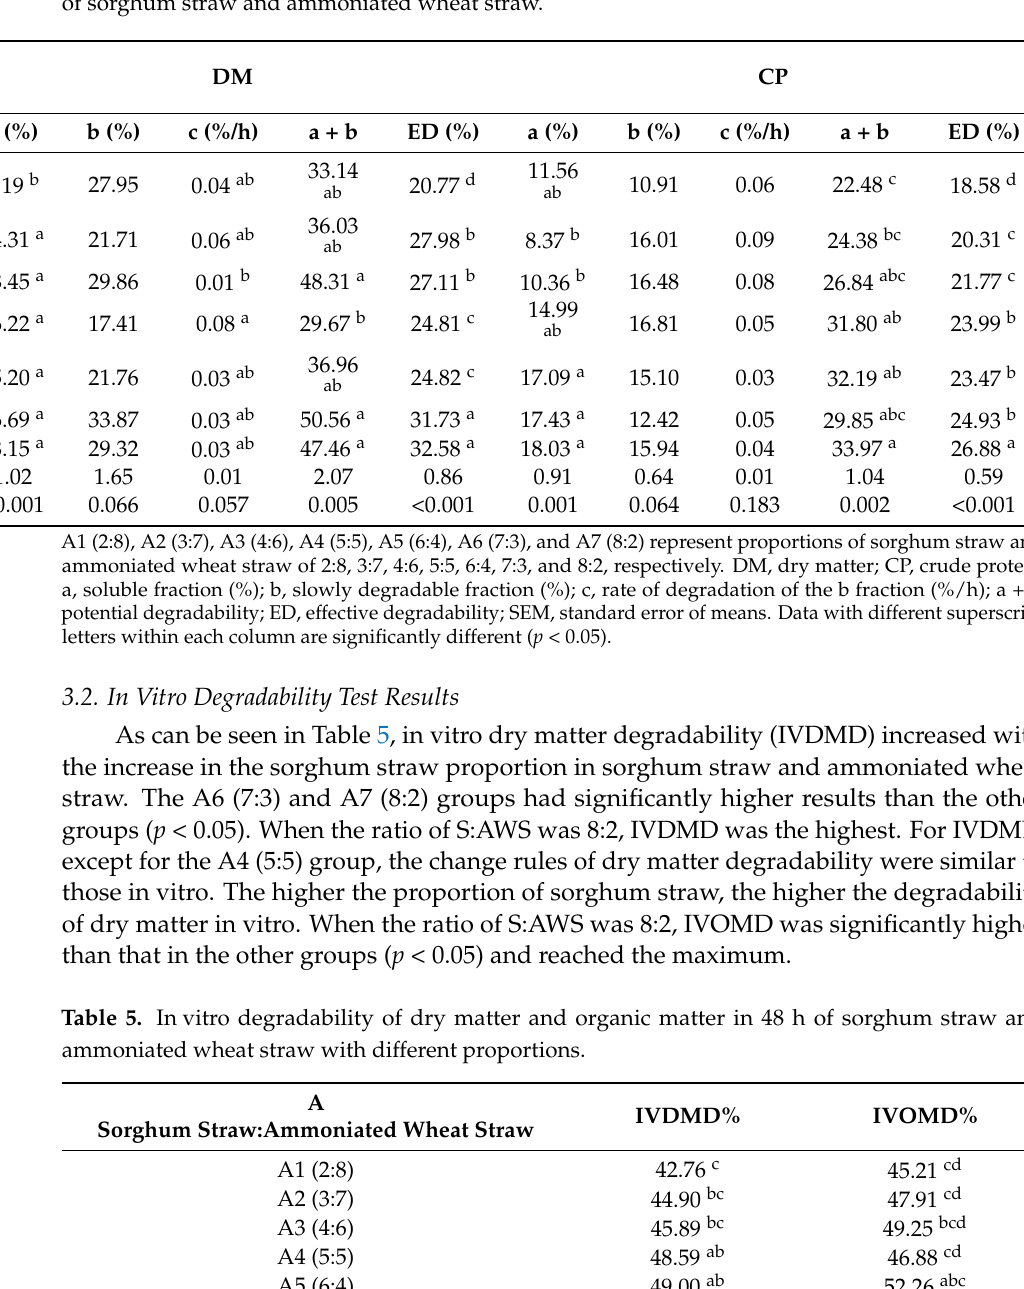
Table 4. Rumen kinetic parameters and effective degradability of DM and CP in different proportions of sorghum straw and ammoniated wheat straw.